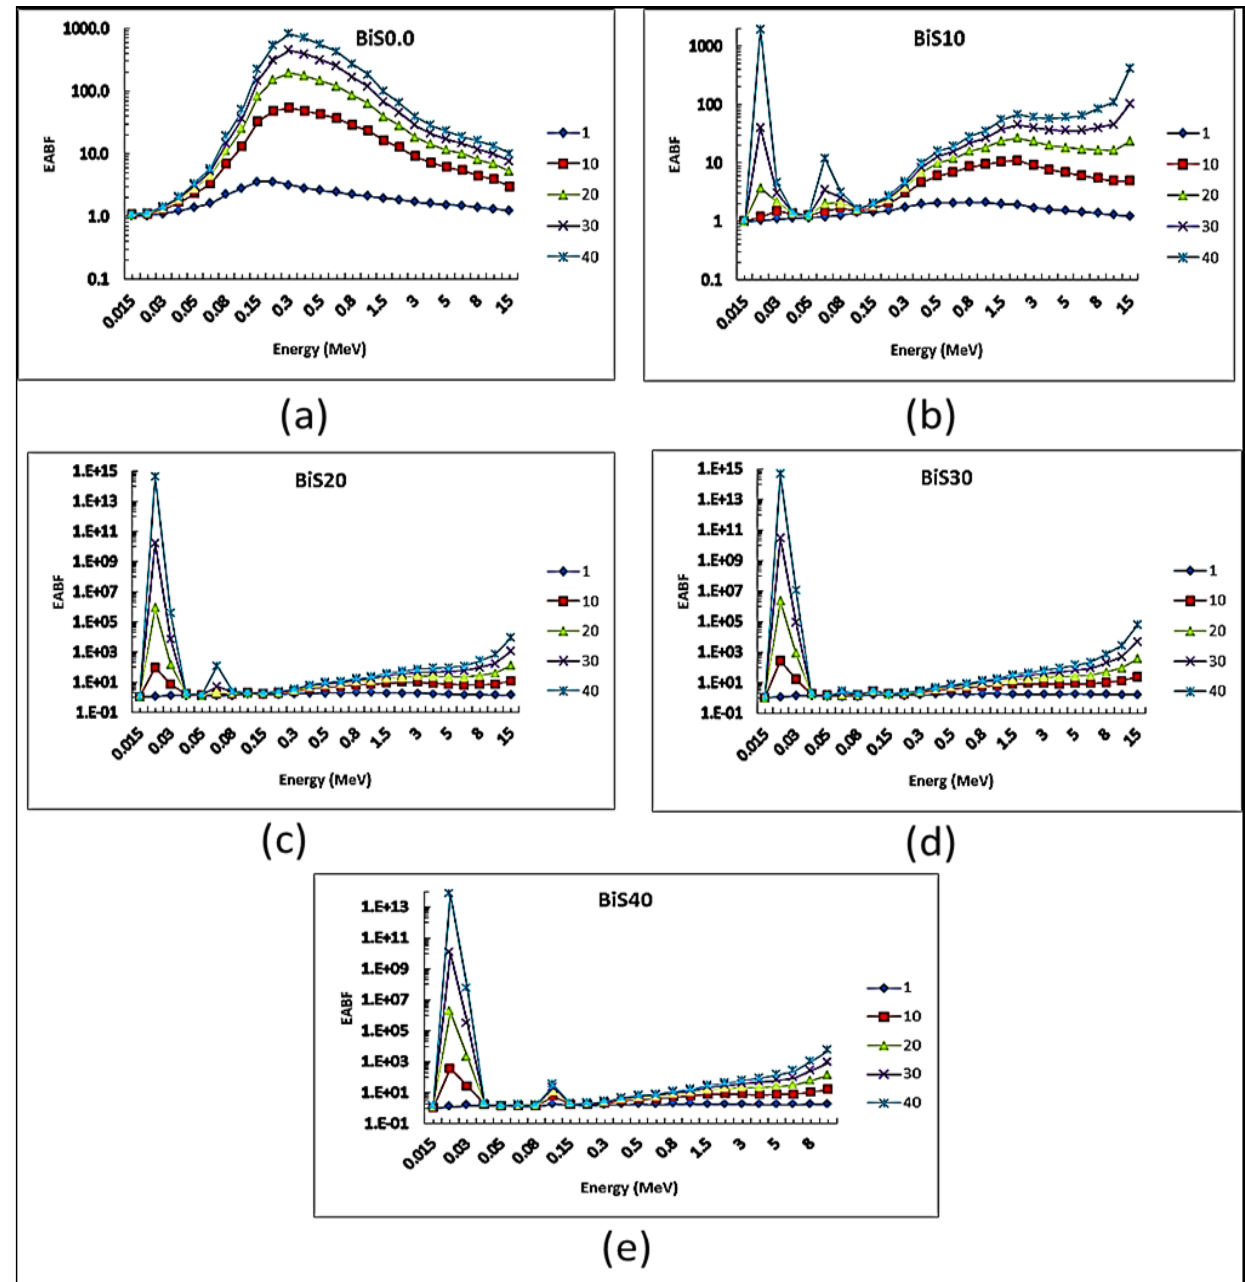
Figure 14. EABF depending on photon energy for all present glass samples: ( a ) Bi0.0, ( b ) Bi10, ( c ) Bi20, ( d ) Bi30, ( e ) Bi40. ( c ) Bi20, ( d ) Bi30, ( e )